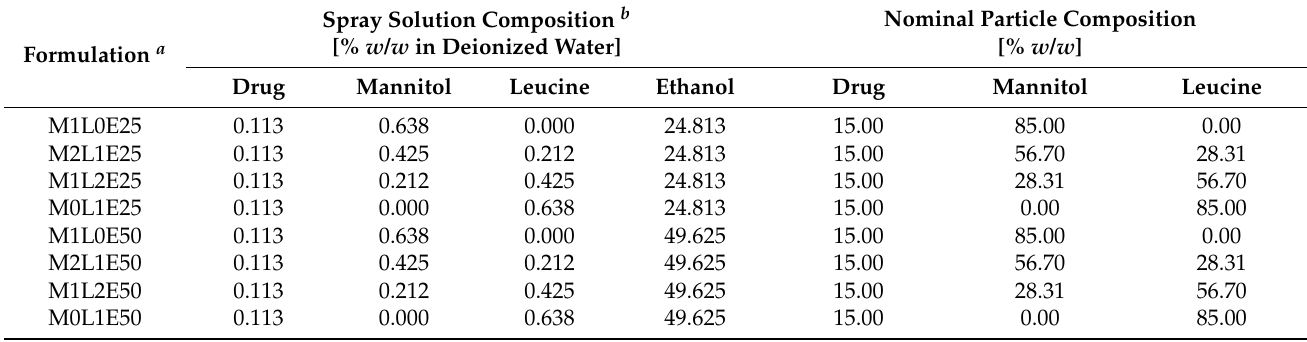
Table 1. The design of the spray drying